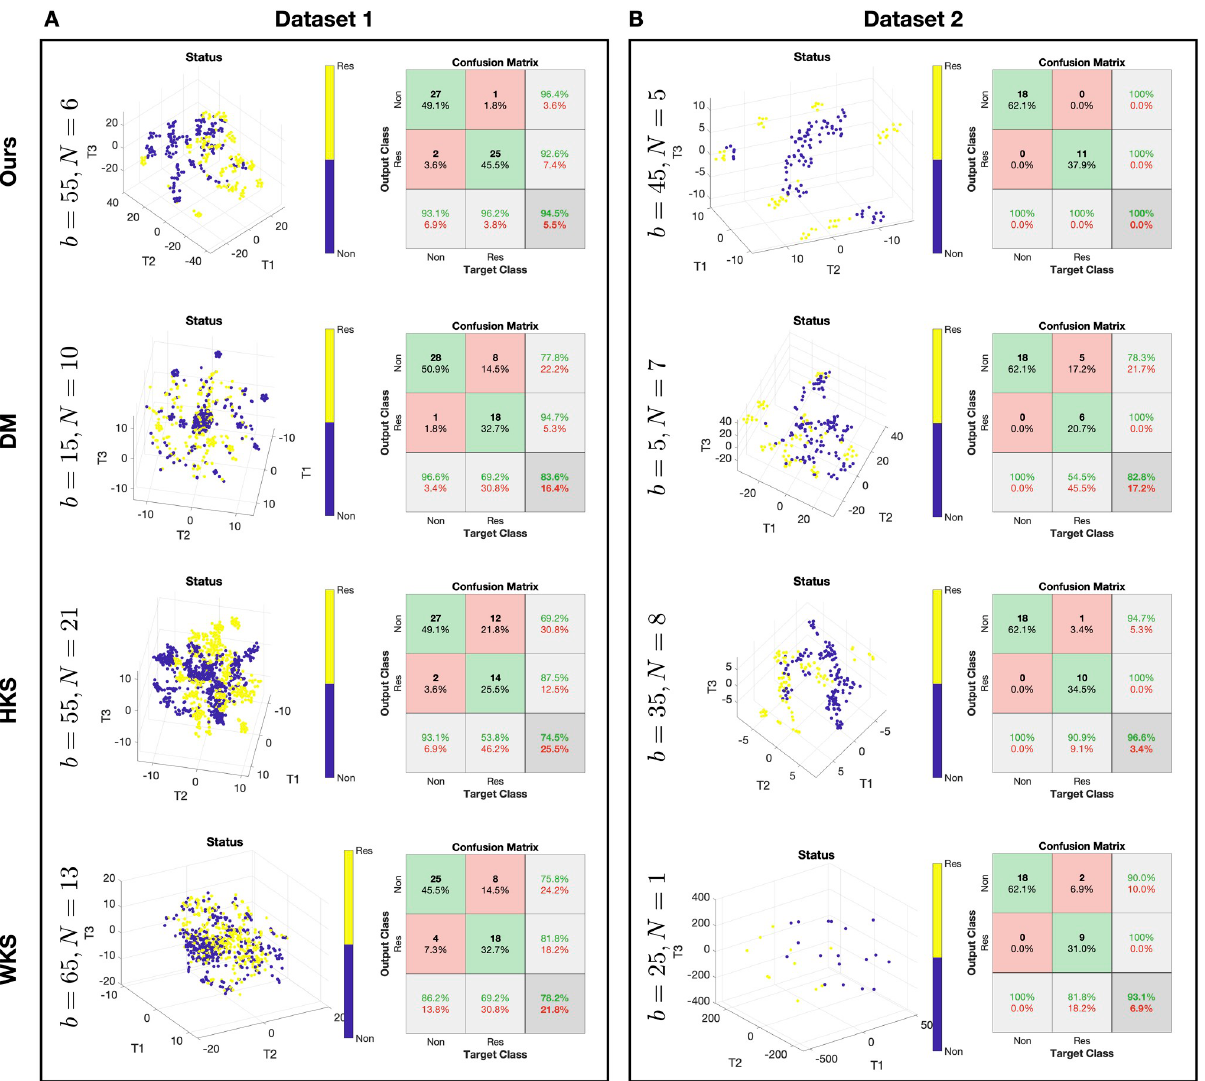
Fig 3. Treatment response predictions. (A) Prediction for Dataset 1. (B) Prediction for Dataset 2. In each panel, at each row, we plot the best algorithm configuration, the 3D t-SNE visualization of the patches representation colored by the response status, and the confusion matrix of the